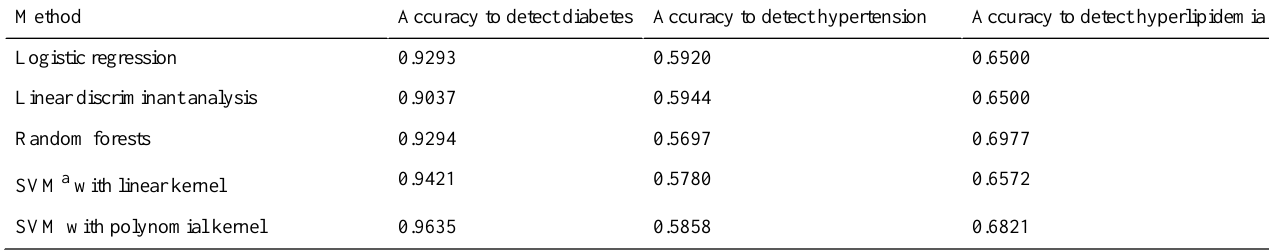
Table 5. Physiological significance of pulse wave parameters.